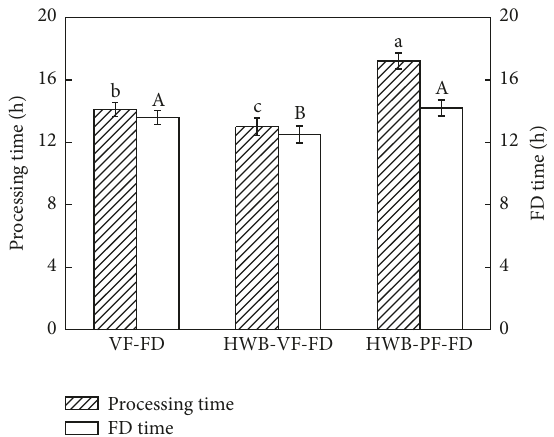
Figure 3: Processing time and FD time in 3 freeze-drying meth- ods. VF-FD: apple samples without hot-water pretreatment were performed with vacuum freezing treatment and freeze-drying process; HWB-VF-FD: apple samples with hot-water pretreatment were performed with vacuum freezing treatment and freeze-drying process; HWB-PF-FD: apple samples with hot-water pretreatment were performed with plate freezing treatment and freeze-drying process. Note . Different letters on the same bars indicate significant differences at 𝑝 = 0.05 by Tukey’s HSD